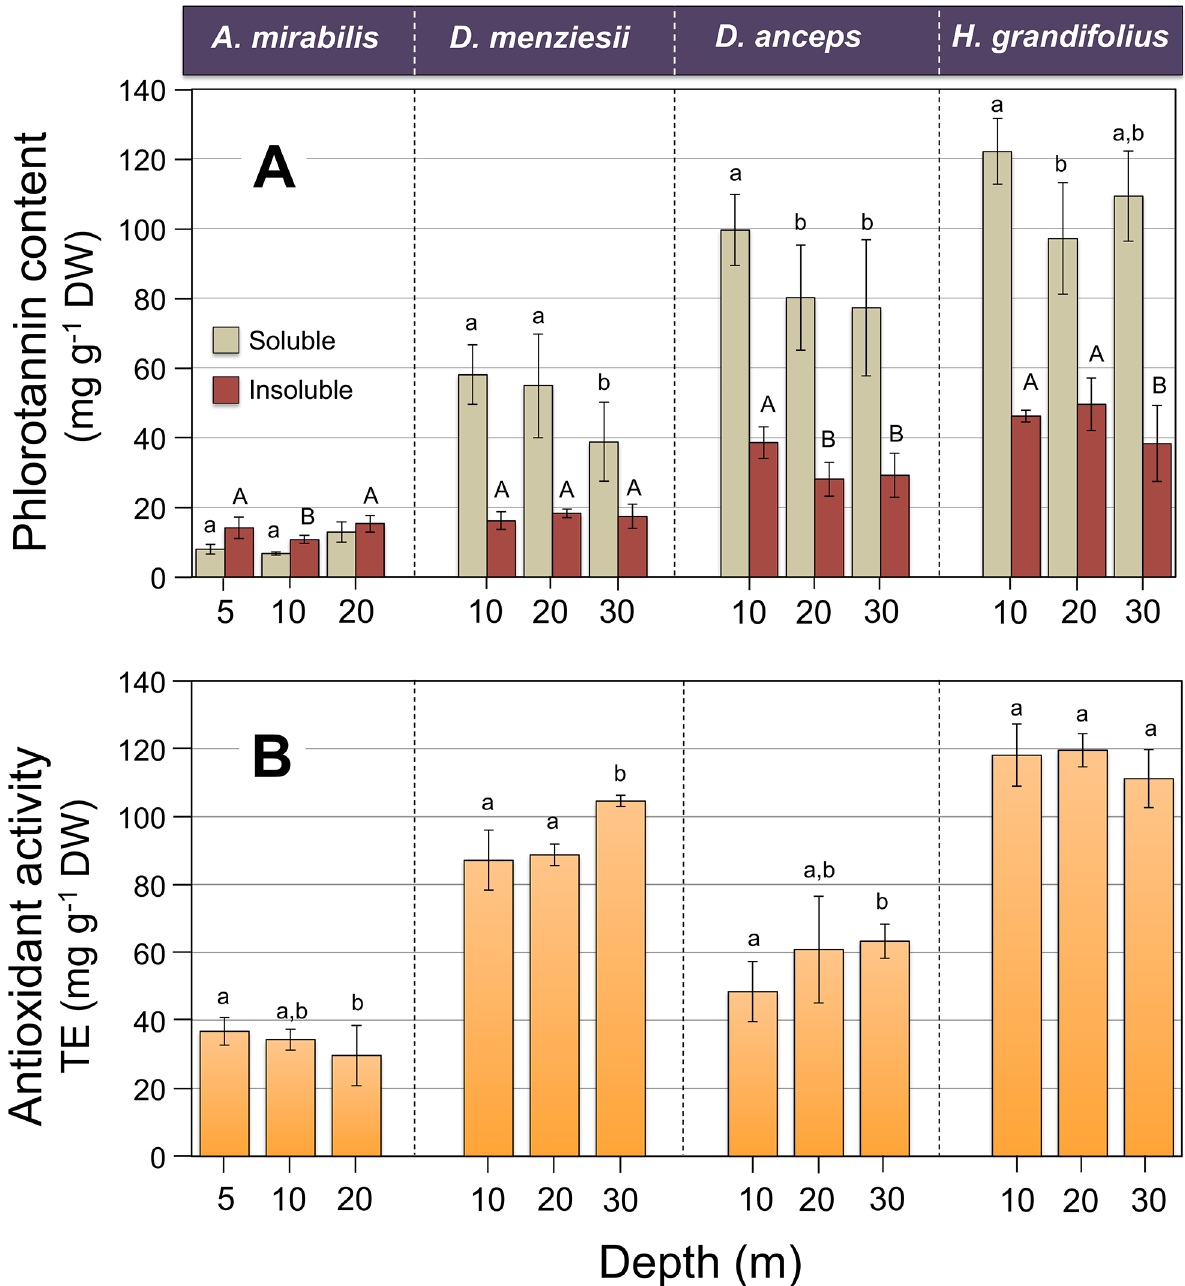
Fig 4. Vertical variation in contents of soluble and insoluble phlorotannins (A) and antioxidant capacity (B) determined in extracts of four species of brown algae collected at three different depths at Fildes Bay. Values are means ± S.D., n = 6 – 9. Similar letters connect homogeneous means following ANOVA and Tukey HSD post-hoc